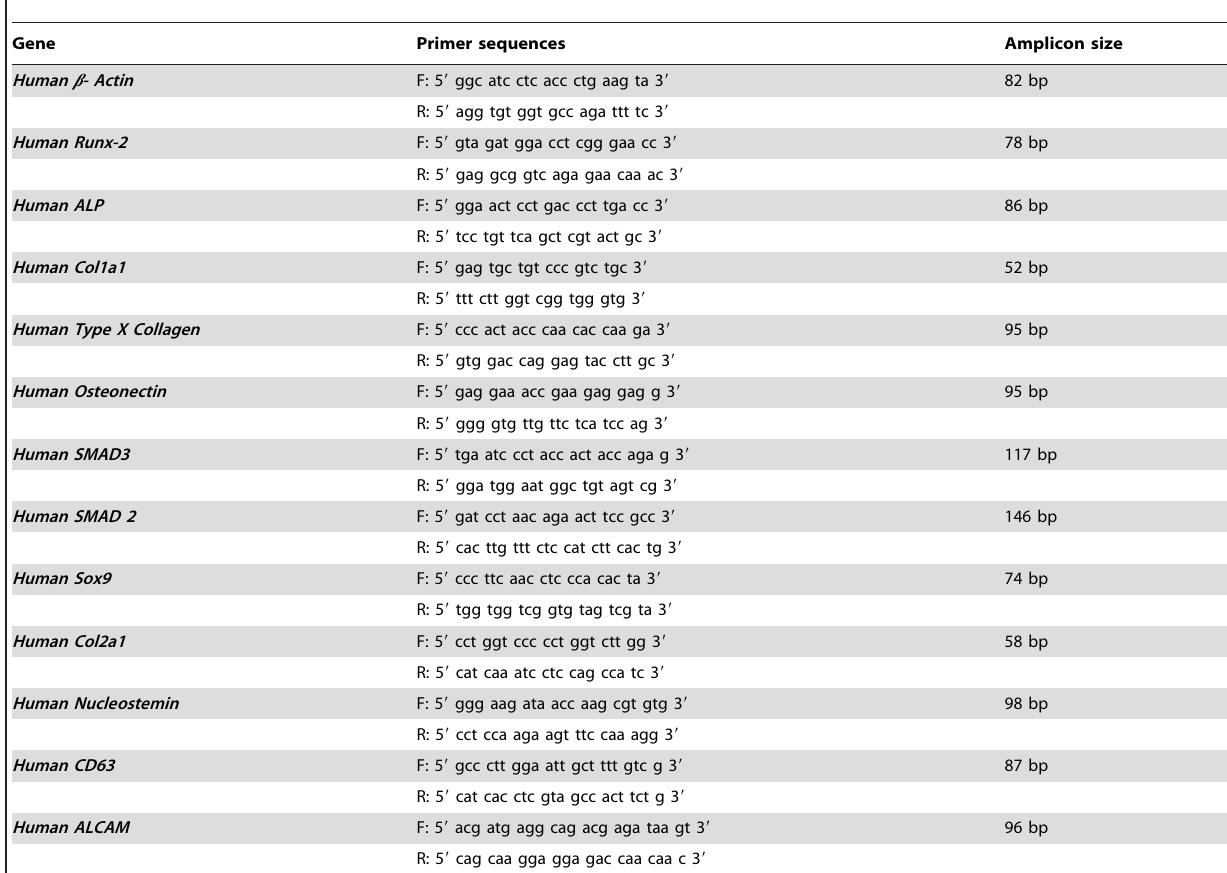
Table 1. Forward and reverse primers sequence used for